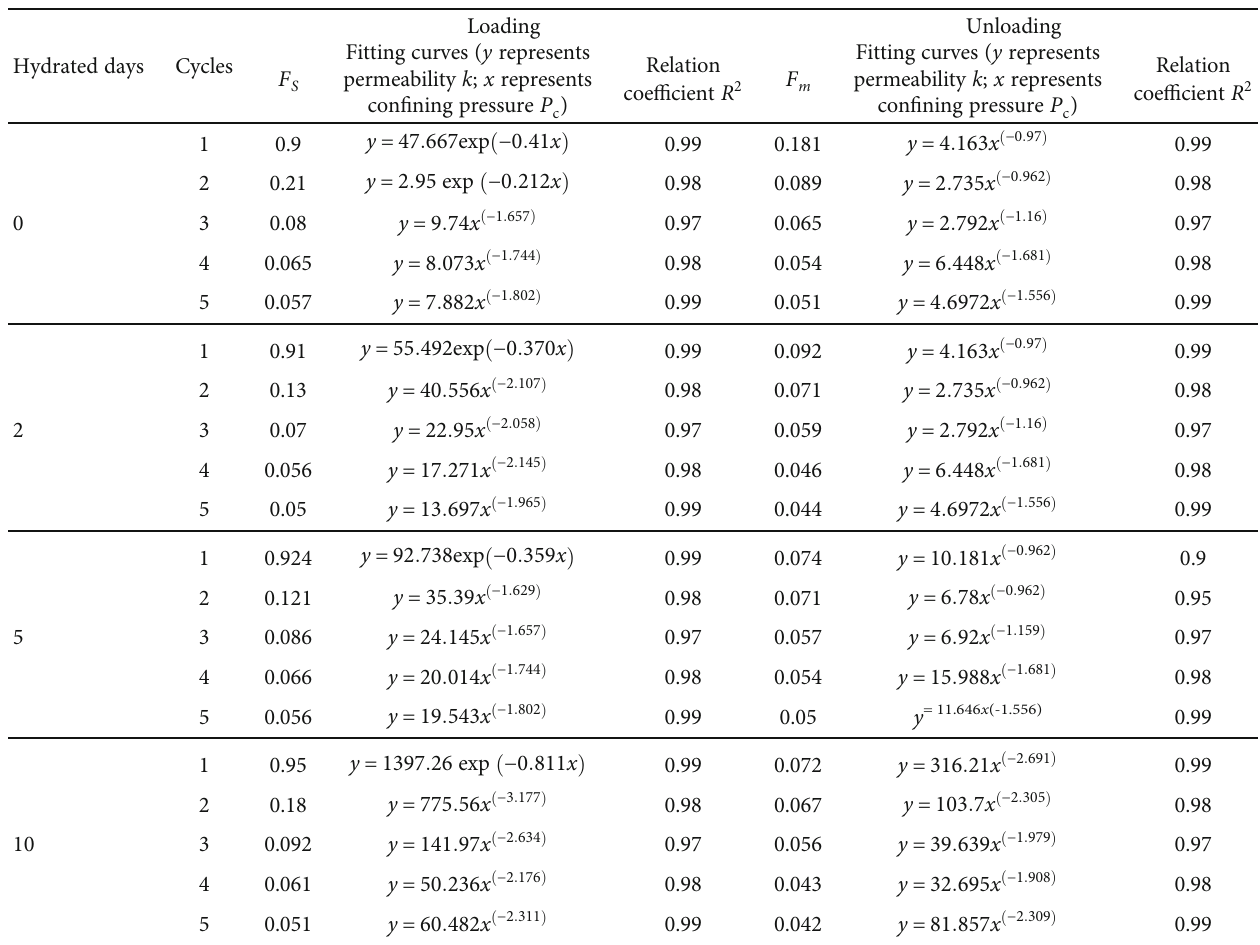
Table 3: Curves of permeability and con fi ned pressure of hydrated shale